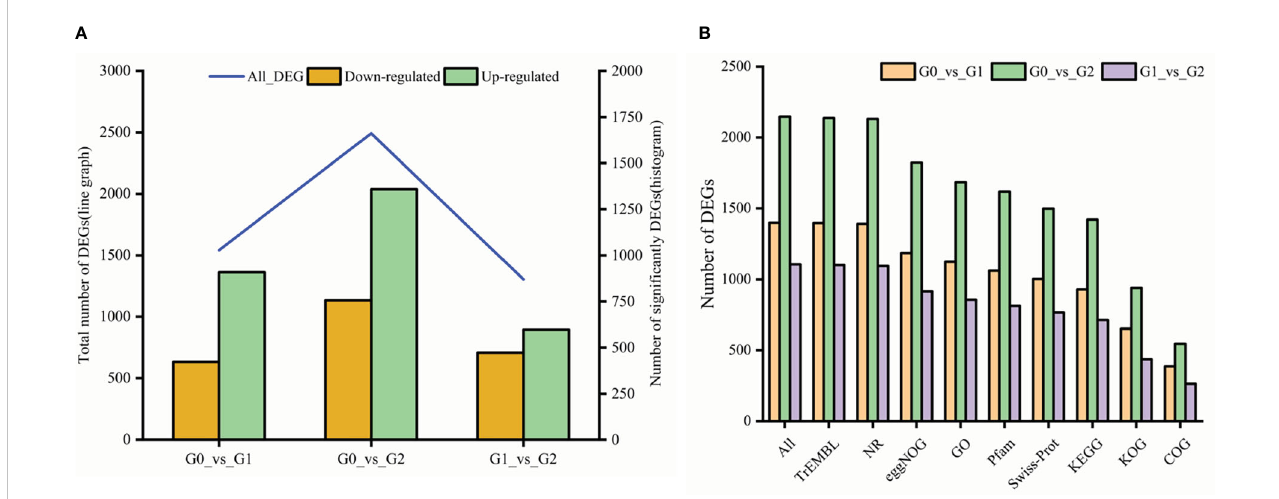
FIGURE 7 The number of differentially expressed genes (DEGs) and their functional annotations to seven public databases. (A) The number of DEGs were upregulated or downregulated in three groups. (B) All represent a total number of genes annotated in at least one the public database: TrEMBL, Translation of EMBL; NR, non-redundant nucleotide sequences; eggNOG, A database of orthologous groups of genes; GO, Gene Ontology; Pfam, Protein families; Swissprot, Swiss-Protein; KEGG, Kyoto Encyclopedia of Genes and Genomes; KOG, Eukaryotic Orthologous Groups and COG, Clusters of Orthologous Groups of